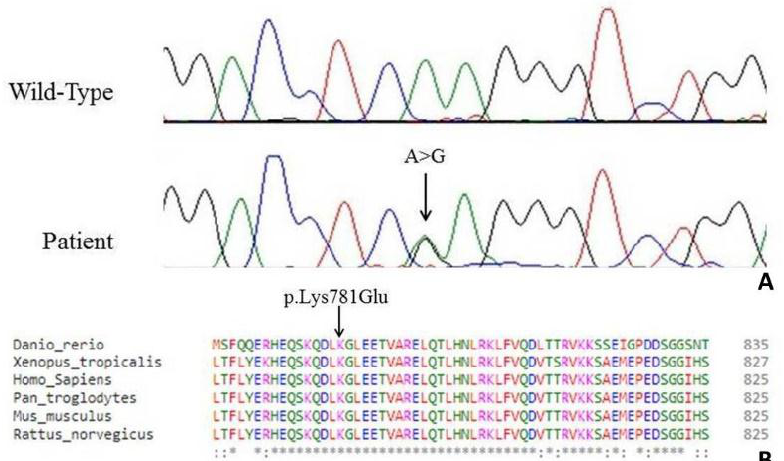
Figure 2. ( A ) Electropherogram showing the novel heterozygote variant c.2341A>G in the exon 21 in the patient compared to a control sequence. ( B ) A partial alignment of KIF5A from different species showing the residue Lys781 located within the terminal region of the stalk domain and highly evolutionary conserved.